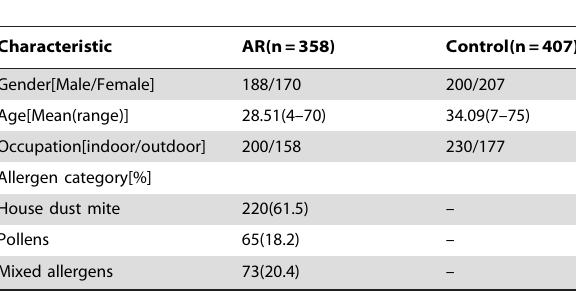
Table 1. Clinical features and demographic characteristics of the study